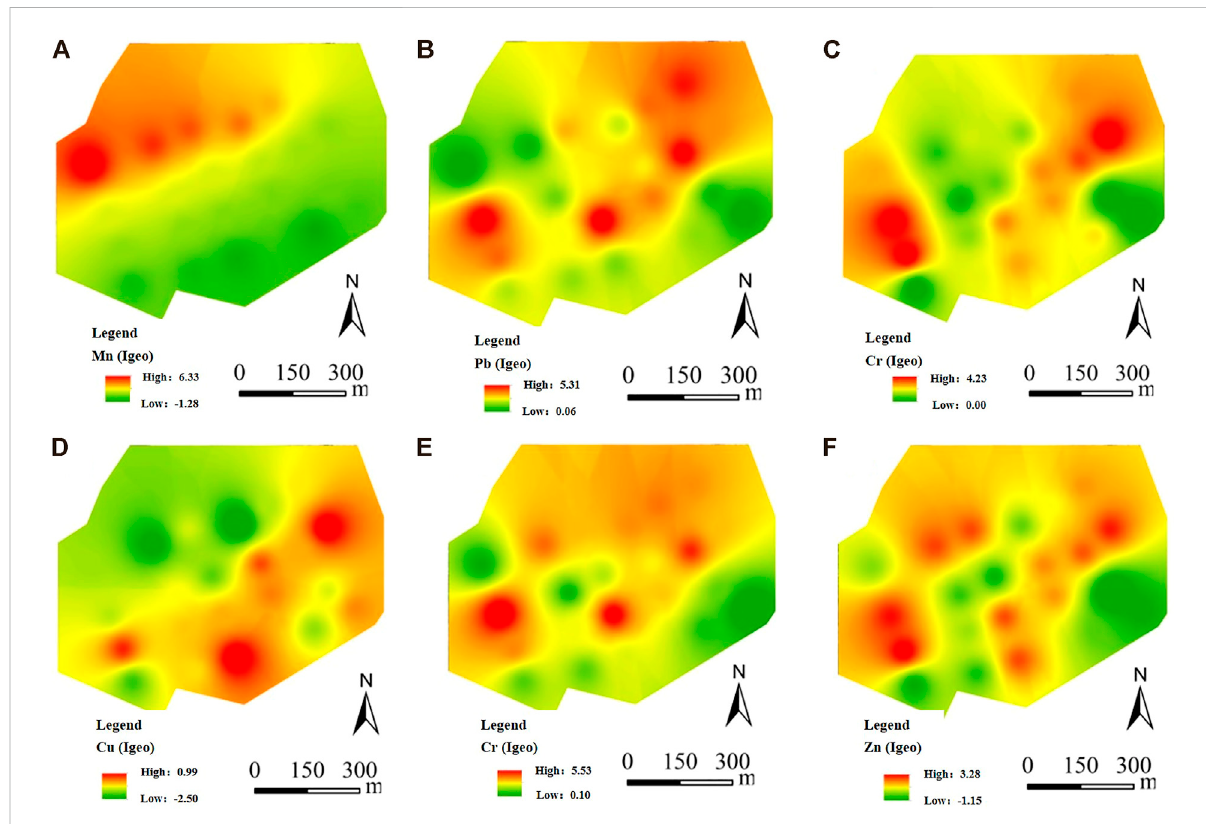
FIGURE 4 Spatialdistributioncharacteristicmapsofheavymetal[ (A – F) :Mn,Pb,Cu,Cr,Cd,andZn]geoaccumulationindex(Igeo)maps.Heavypollutionis red and light pollution is